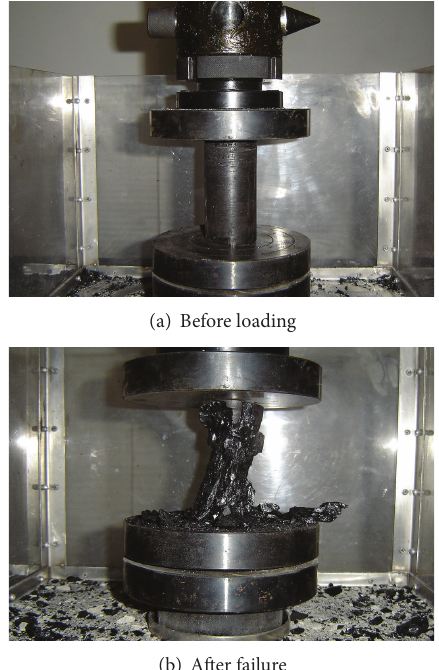
Figure 3: Photographs of LM3# coal sample before and after